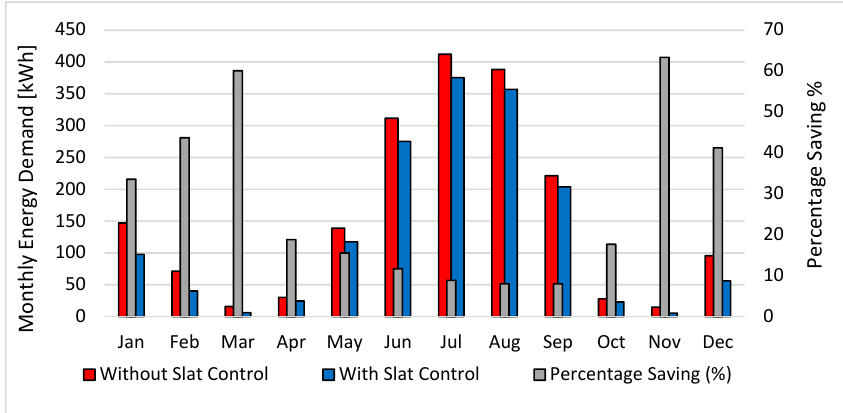
Figure 7. Monthly energy demand and percentage saving.